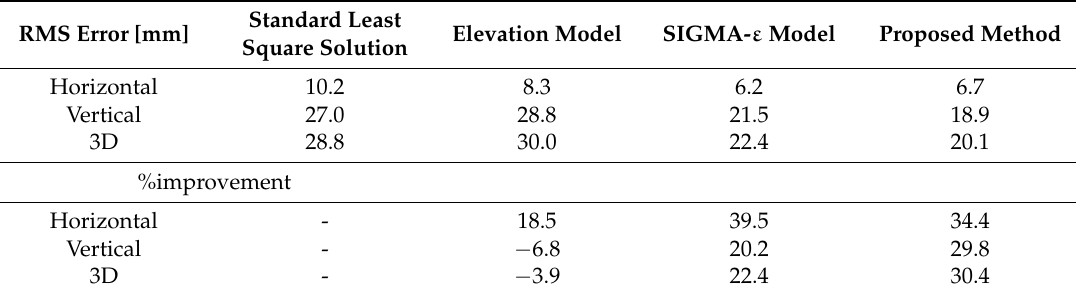
Table 10. RMS errors in horizontal and height components and their percentage improvement (when comparing with the results of other stochastic models) of the tested stochastic models based on the proposed method in Dataset KTE1.